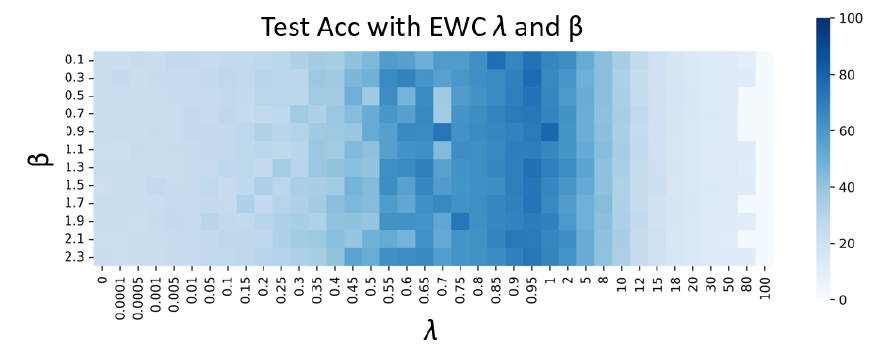
Figure 10. Variation of model accuracy under different combinations of λ and β